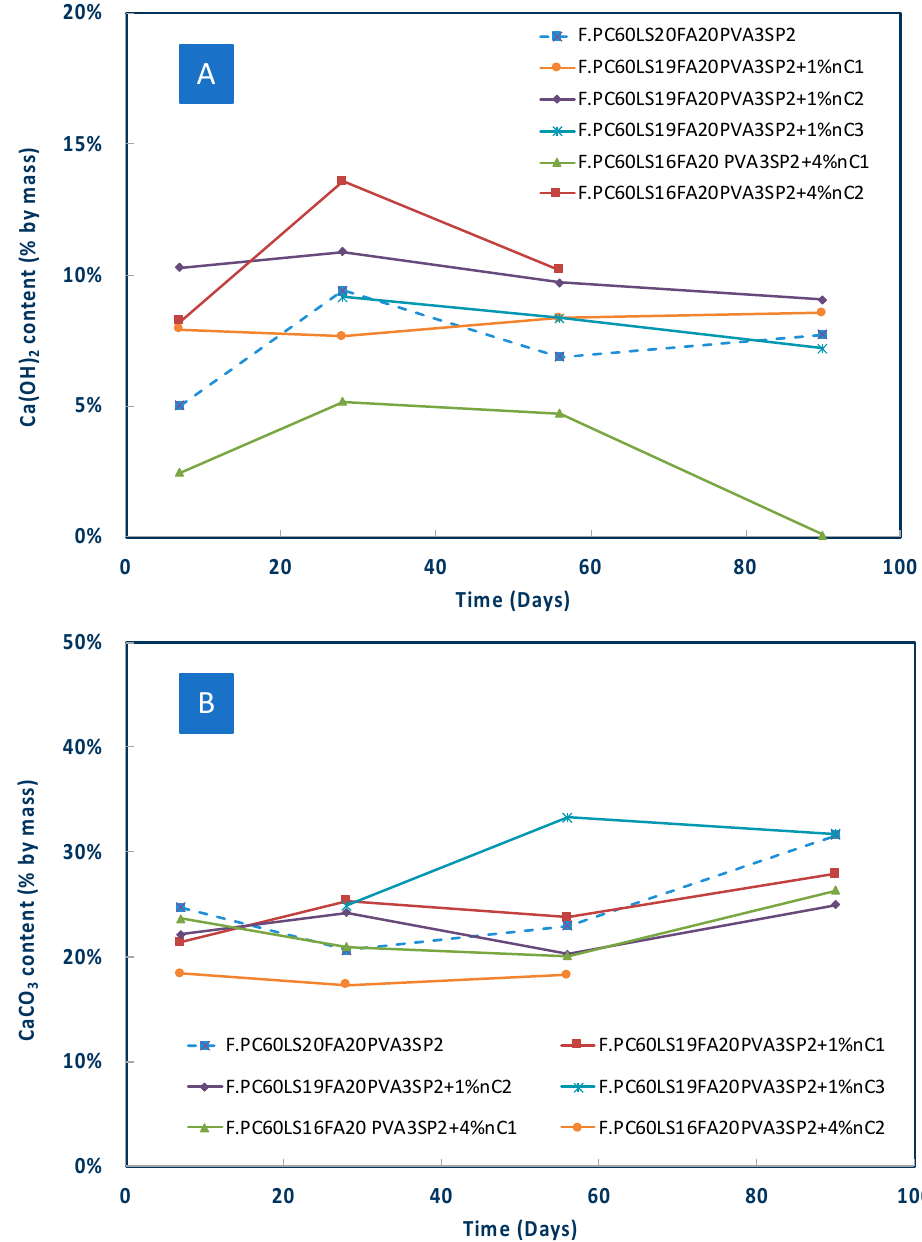
Figure 8. E ff ect of nMt content and type on ( A ) Ca(OH) 2 and ( B ) CaCO 3 content of nMt and fibre reinforced cementitious nanocomposites based on F.PC60LS20FA20PVA3SP2.